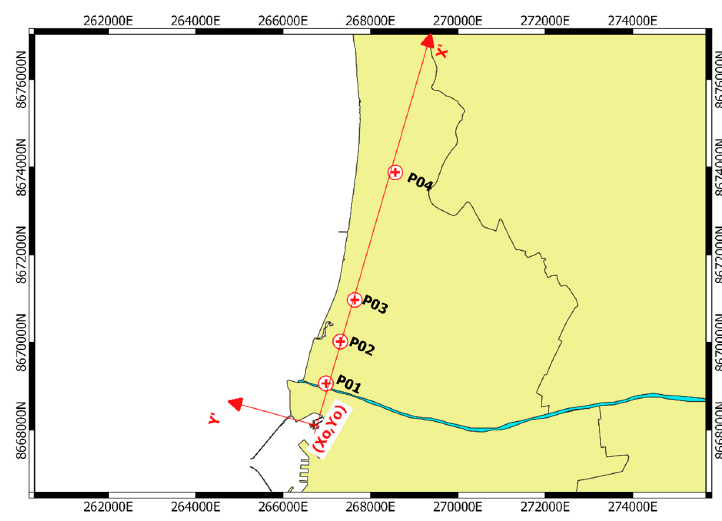
Figure 5. New coordinate system and control points defined in study area.